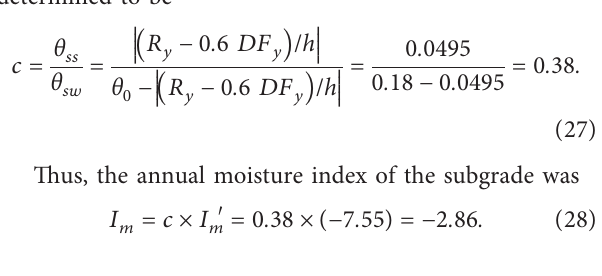
Table 4. The pavement coverage correction coefficient c was